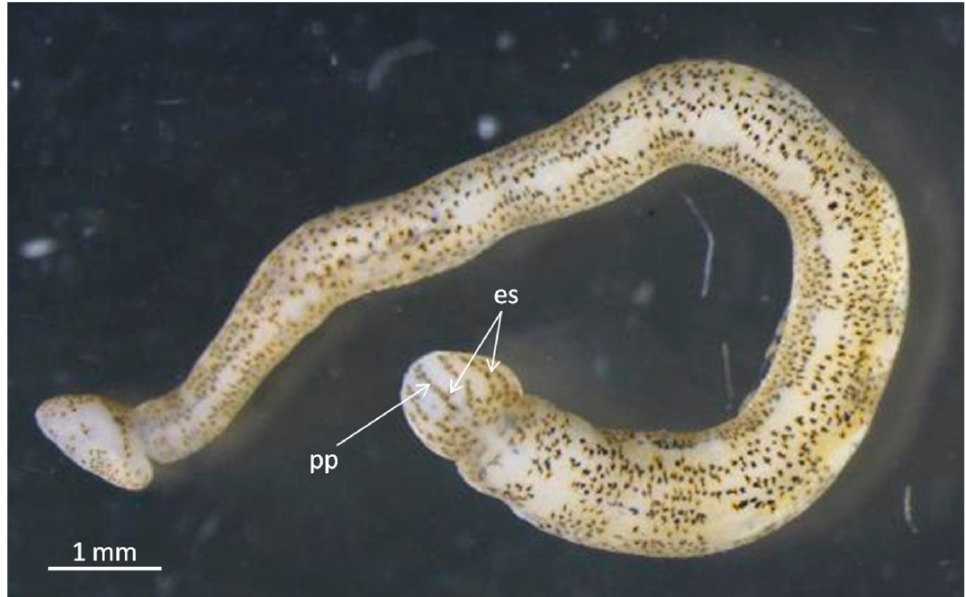
Figure 8. Appearance of the Piscicola leech from Lake Superior, United States. The image of the specimen EINVA400_19 was retrieved from https://www.boldsystems.org (accessed on 10 January 2023). Arrows indicate pigmented pattern (pp) and eye-like spots (es) on the caudal sucker.